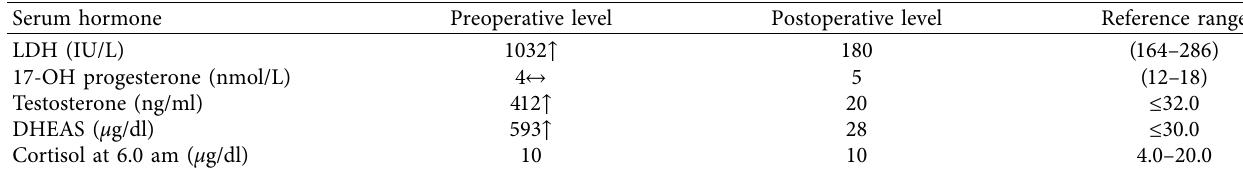
Table 3: Preoperative and postoperative (after 5 days) hormonal profile.